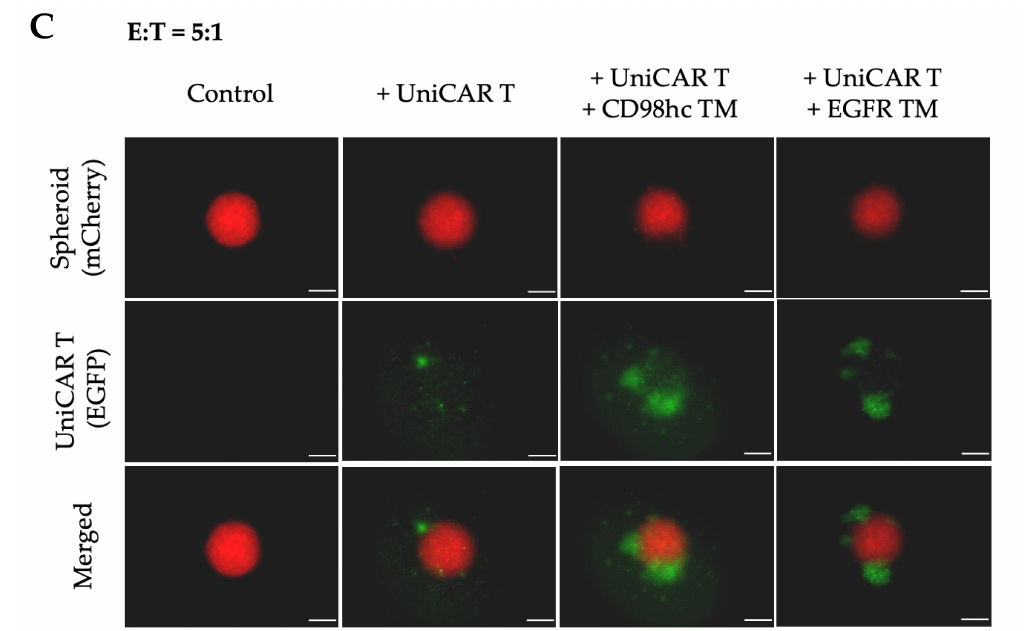
Figure 2. CD98hc-redirected UniCAR T cells destroy Cal33 RR spheroids. ( A ) Scheme of procedures for multicellular spheroid formation, UniCAR T treatment, and standard chromium release assay. Created with https://biorender.com, accessed on 31 January 2022. ( B ) Chromium release assay and flow cytometry analysis showed the efficient elimination of Cal33 RR spheroid cells by UniCAR T cells in the presence of CD98hc TM (50 nM). ( C ) Representative fluorescence images of Cal33 RR spheroids treated with UniCAR T cells in the presence or absence of CD98hc or EGFR TM. Fluorescence images were taken with Axio Observer Z1 (Zeiss, Jena, Germany). Cal33 RR spheroid: red fluorescence, UniCAR T: green fluorescence. Scale bar: 200 µ m. Experiments were performed in triplicates. Paired or nonpaired t -test were applied to calculate the statistical significance of the treatment efficacy (treated vs. control spheroids); error bars, mean ± SEM. * p < 0.05, ** p < 0.01. Cr: Chromium; EGFP: Enhanced green fluorescent protein; E:T: Effector-to-target ratio; NS TM: Nonspecific target module; n.s.: not